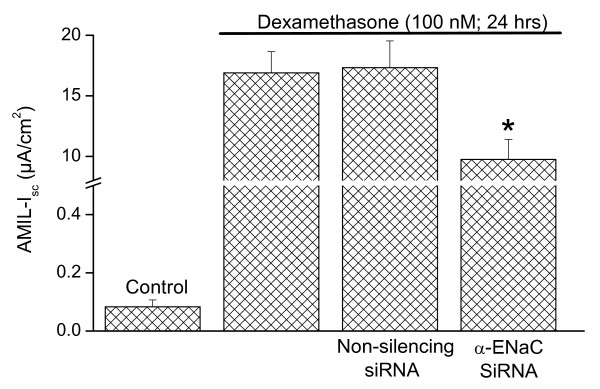
Effect of RNA interference on short circuit current of SCCD epithelium. Effect of α-ENaC siRNA on dexamethasone stimulated Na+ transport: Epithelia were incubated with dexamethasone (100 nM) for 24 hr concurrently with transfection. Amiloride-sensitive short circuit current, AMIL-Isc, was measured from both transfected and non-transfected monolayers as a function of net Na+ transport. α-ENaC siRNA (anti-sense) but not non-silencing siRNA (sense) inhibits dexamethasone-stimulated Na+ transport. "Control" epithelia were not incubated with dexamethasone. Data are mean ± SEM, n = 3 - 10. P < 0.05 (*) compared to AMIL-Isc with dexamethasone alone. Note the break in the vertical axis.